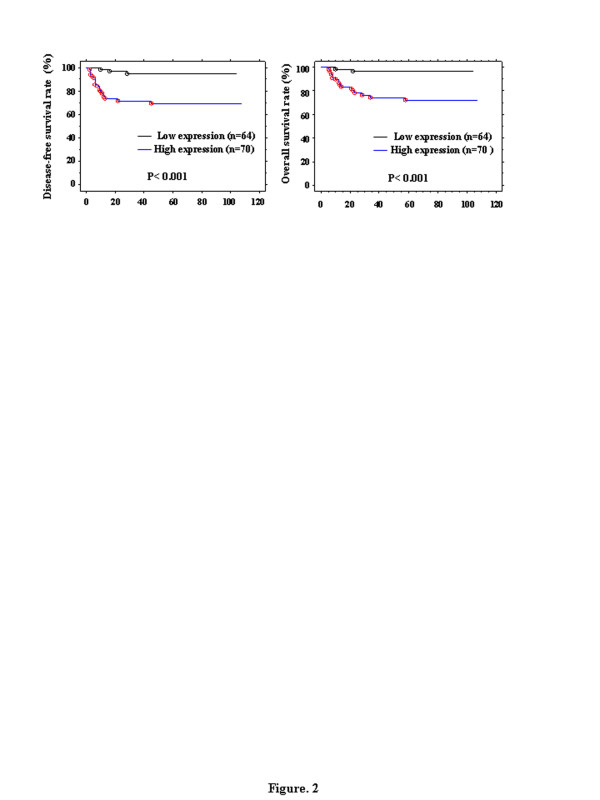
Disease-free survival (DFS) and overall survival (OS) rates of the 134 patients with endometrial cancer according to the emmprin expression status. Low epithelial expression, scores 0–1; high epithelial expression, score 2.